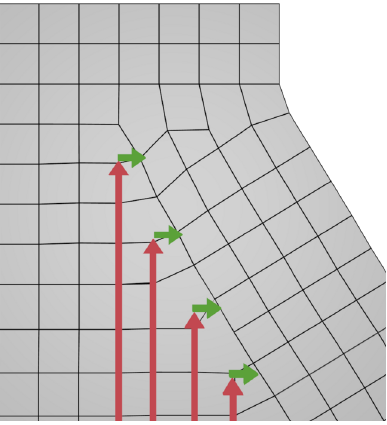
Figure 9: A disclination can be thought of as an infinite stack of dislocations, every next one translated in the direction of their Burgers